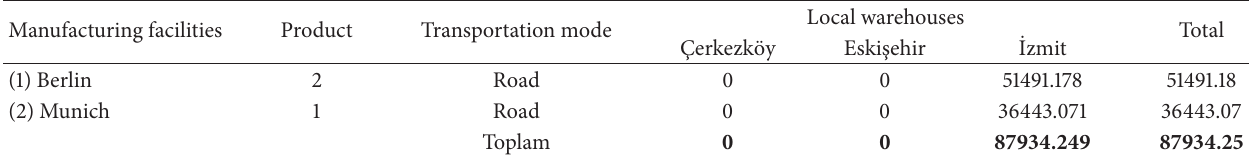
Table 21: Transportation quantities from manufacturing facilities to local warehouses.